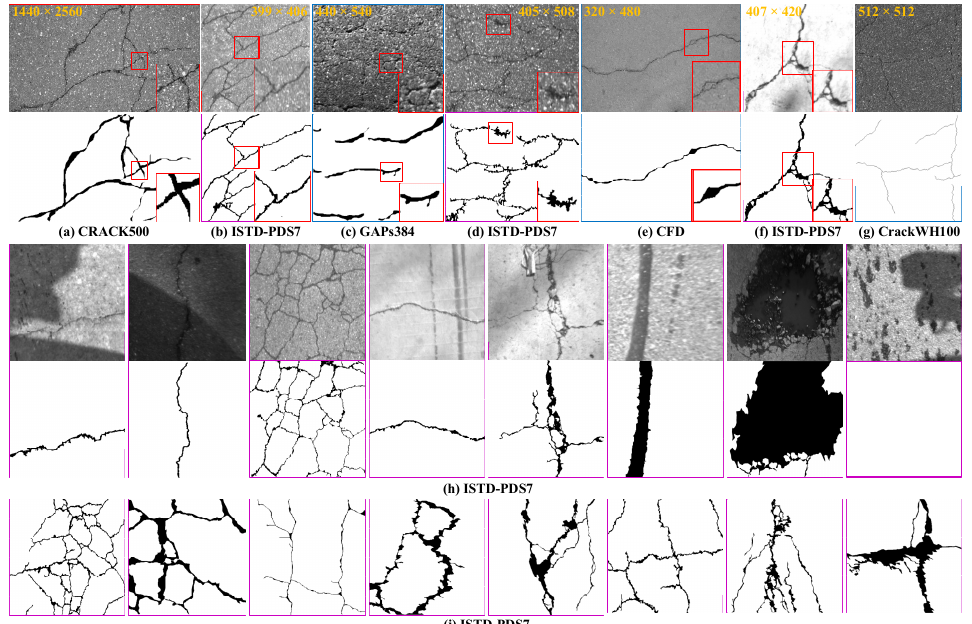
Figure 6. Qualitative comparison of the different datasets: ( a – d ) indicate that ISTD-PDS7 provides more detailed crack labeling; ( e , f ) show the differences in detail labeling between the CFD [37] dataset and the ISTD-PDS7 dataset; ( g ) is a sample of the CRACKWH100 dataset [30], which was annotated manually with a single-pixel width; ( h ) shows labeling cases of seven types of distress and negative samples in complex scenarios; and ( i ) demonstrates the structural complexity and diversity of the alligator network cracks within the ISTD-PDS7